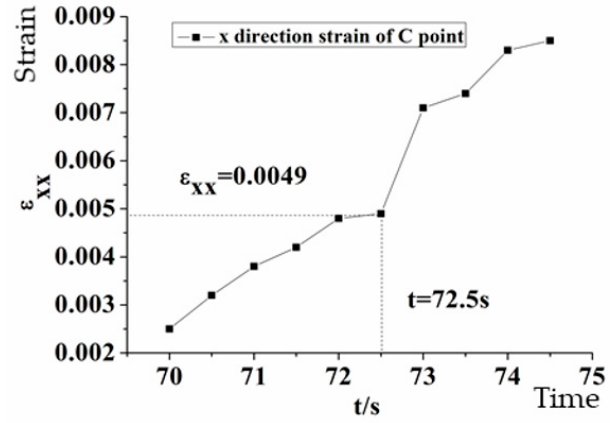
Figure 16. X-direction strain–time relationship at point C (loading rate = 0.3 MPa/s).